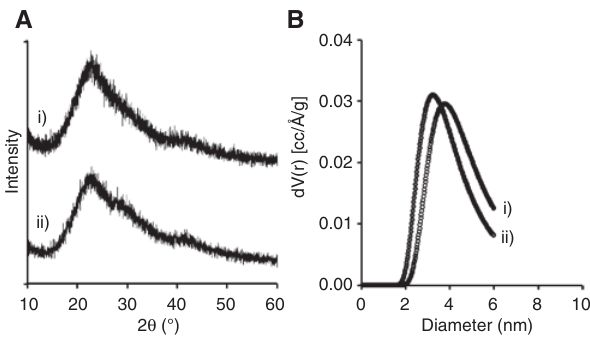
Figure 3: (A) X-ray diffraction (XRD) spectra and (B) pore size distributions of porous nanosilica (PNS) (i) and PNSC (ii).